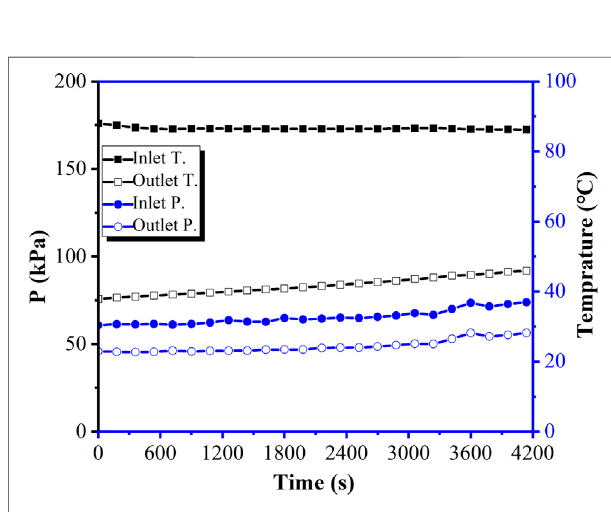
FIGURE 4 | Temperature and pressure in the inlet and outlet